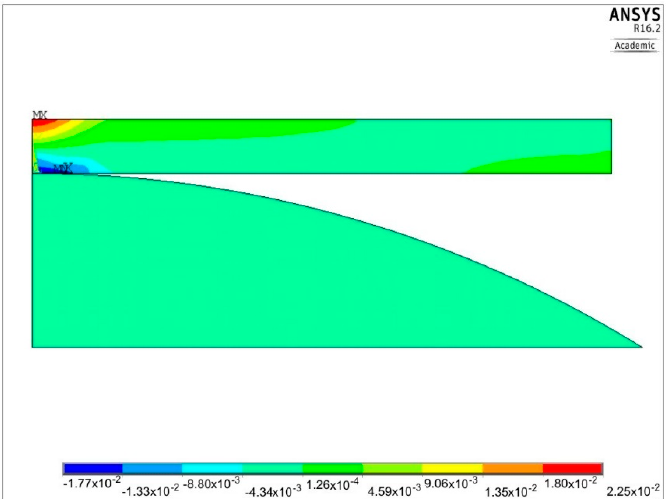
Figure 9. Distribution of the first principal strain ε 1 produced by the second loading semi-cycle, for ∆ U 3 = 334.2 μ m.